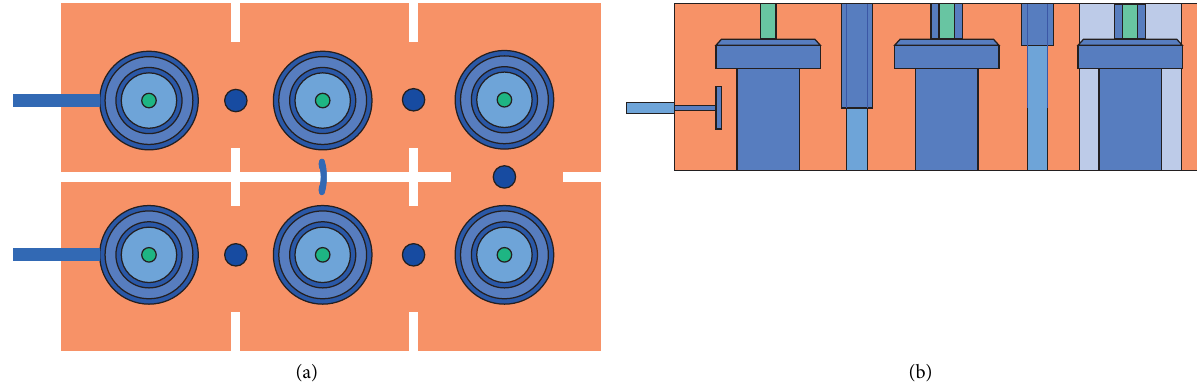
Figure 4: Top view and side view of sixth-order cross-coupling filter. (a) Top view. (b) Side